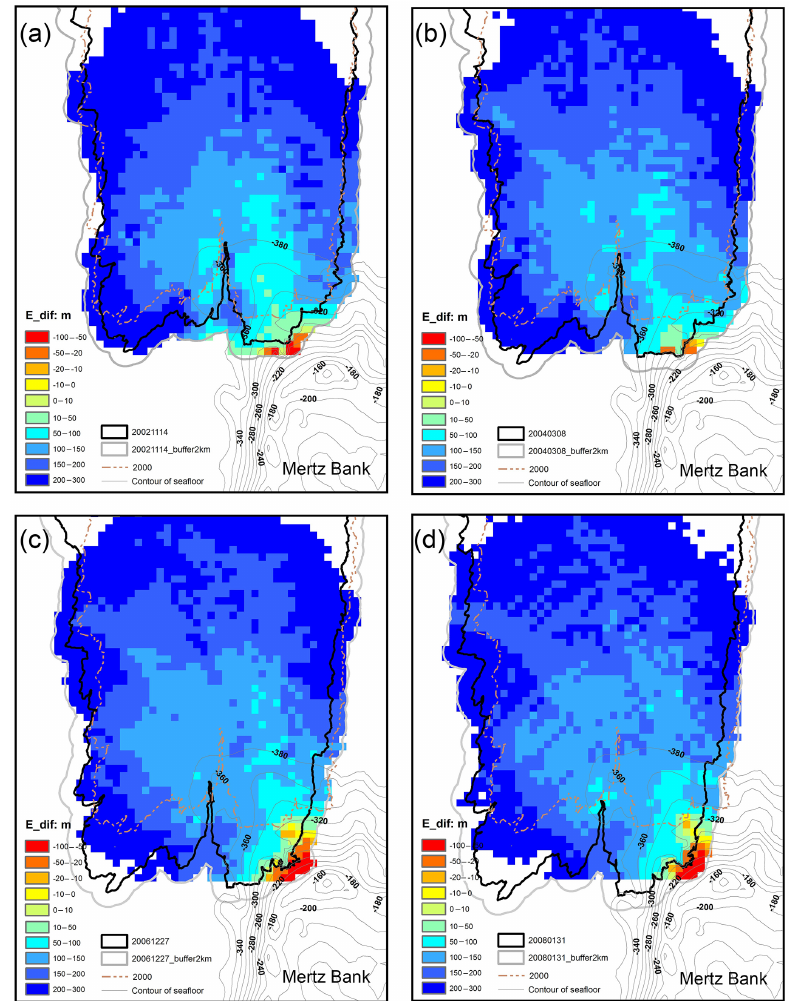
Figure 6. Elevation difference of Mertz ice bottom and seafloor topography. (a, b, c, d) correspond to the elevation difference from 14 Novem- ber 2002, 8 March 2004, 27 December 2006, and 31 January 2008, respectively assuming hydrostatic equilibrium under the minimum sea surface height − 3.35m. The contours at an interval of 20m in the lower right indicate the seafloor topography of the Mertz Bank. The solid black line indicates the boundary of the MIT and the thick gray line outlines a buffer region of the boundary with 2km as buffer radius. The dash-dotted line indicates the shape of the MIT on 25 January 2000, which is used to identify the bathymetry gap under the MIT. In the legend, the negative values mean that the ice bottom is lower than the seafloor, which of course is impossible. Therefore, the initial assumption of a floating ice tongue was incorrect in those locations (yellow to red colours), and the ice was grounded. Regions with more negative values indicate heavier grounding inside the MIT or grounding potential in the buffer region. Please note that no bathymetric data were available under most of the ice tongue and for locations of the bathymetric data, please refer to Fig. 3b and